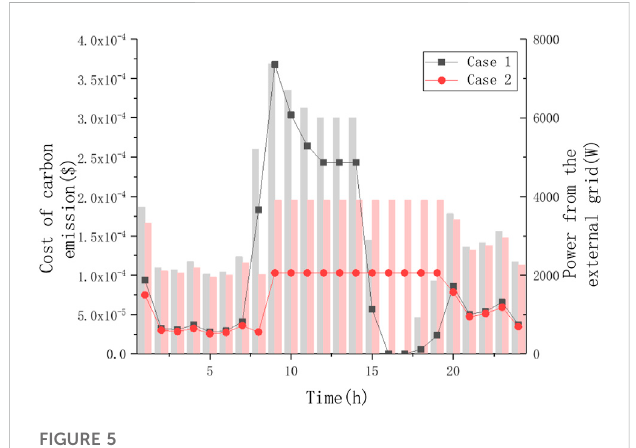
FIGURE 5 Distribution of incremental carbon emission costs in the DA periods.